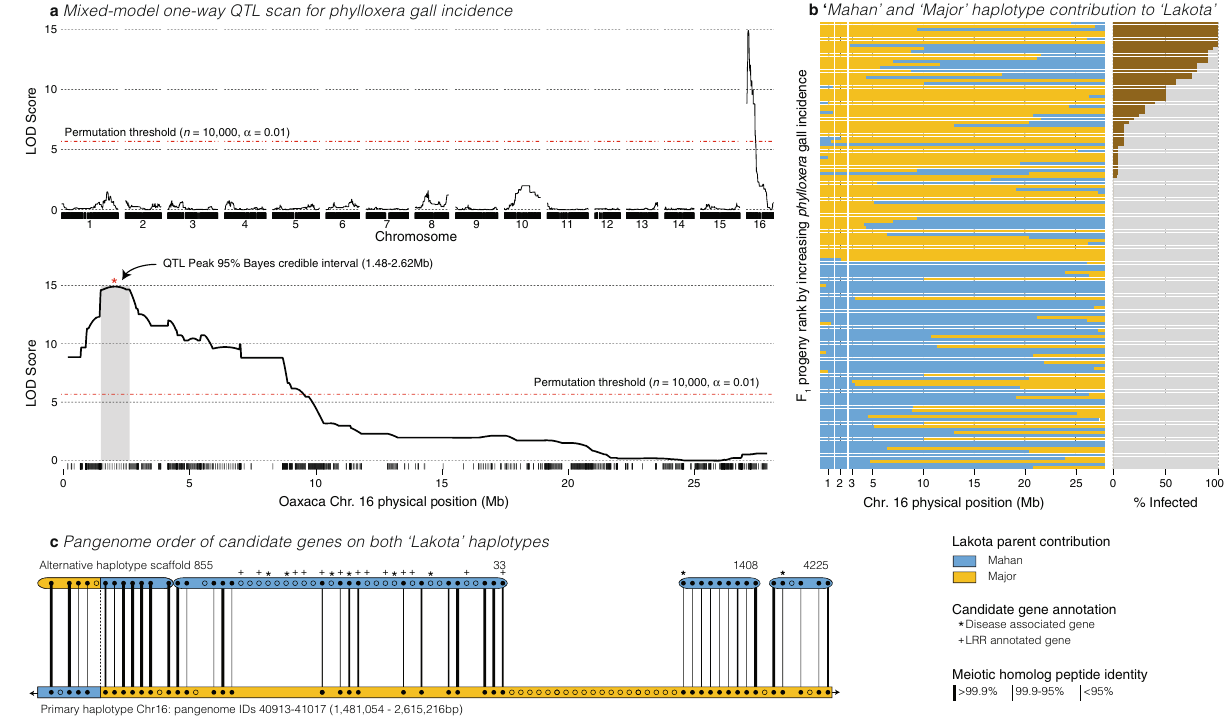
Fig. 3 Analysis of a major QTL for phylloxera resistance. a Quantitative Trait Locus (QTL) scans, controlling for genomic background via the leave-one- chromosome-out method for % phylloxera gall incidence. This experiment was conducted once at a single time point. Since the phenotype is non-normal, we determine the signi fi cance of QTL peaks via 10,000 permutations. The full genome and a close-up visualization of chromosome 16 are presented along the physical position (Mb: megabases) of the ‘ Oaxaca ’ genome assembly. The 95% con fi dence interval surrounding the QTL peak is shaded. b As evidenced by very high LOD scores for a 140-genotype population, there is an extremely strong haplotype structure at the peak QTL (between the vertical white bars), where all but two individuals that inherited the ‘ Mahan ’ haplotype from ‘ Lakota ’ have no evidence of phylloxera galls (gray horizontal bars in the plot to the right), while all individuals with >50% phylloxera gall incidence retained the ‘ Major ’ haplotype at the QTL peak region (brown horizontal bars indicate % incidence). c To de fi ne candidate genes, we queried the pan-genome within the physical bounds (base pairs, bp) of the QTL interval. All unique genes in this interval were projected onto the alternative haplotype; those contigs where >50% of the projected genes were derived from the candidate interval were extracted and aligned to the primary haplotype. Orthologous genes between the two haplotypes are connected by a solid line, the thickness of which is scaled by % identity between the two protein sequences. Presence – absence variant (PAV) genes without a projected ortholog are represented by open circles. Homologs of the genes in the interval were queried in model systems and quali fi ed by whether annotations indicated a disease-related function or a leucine-rich repeat (LRR) motif. Finally, the haplotypes were coded by whether they were derived from the ‘ Mahan ’ or ‘ Major ’ parents of ‘ Lakota ’ . Source data underlying c are provided as a Source Data fi le. Raw data associated with a , b can be found in Supplementary Data